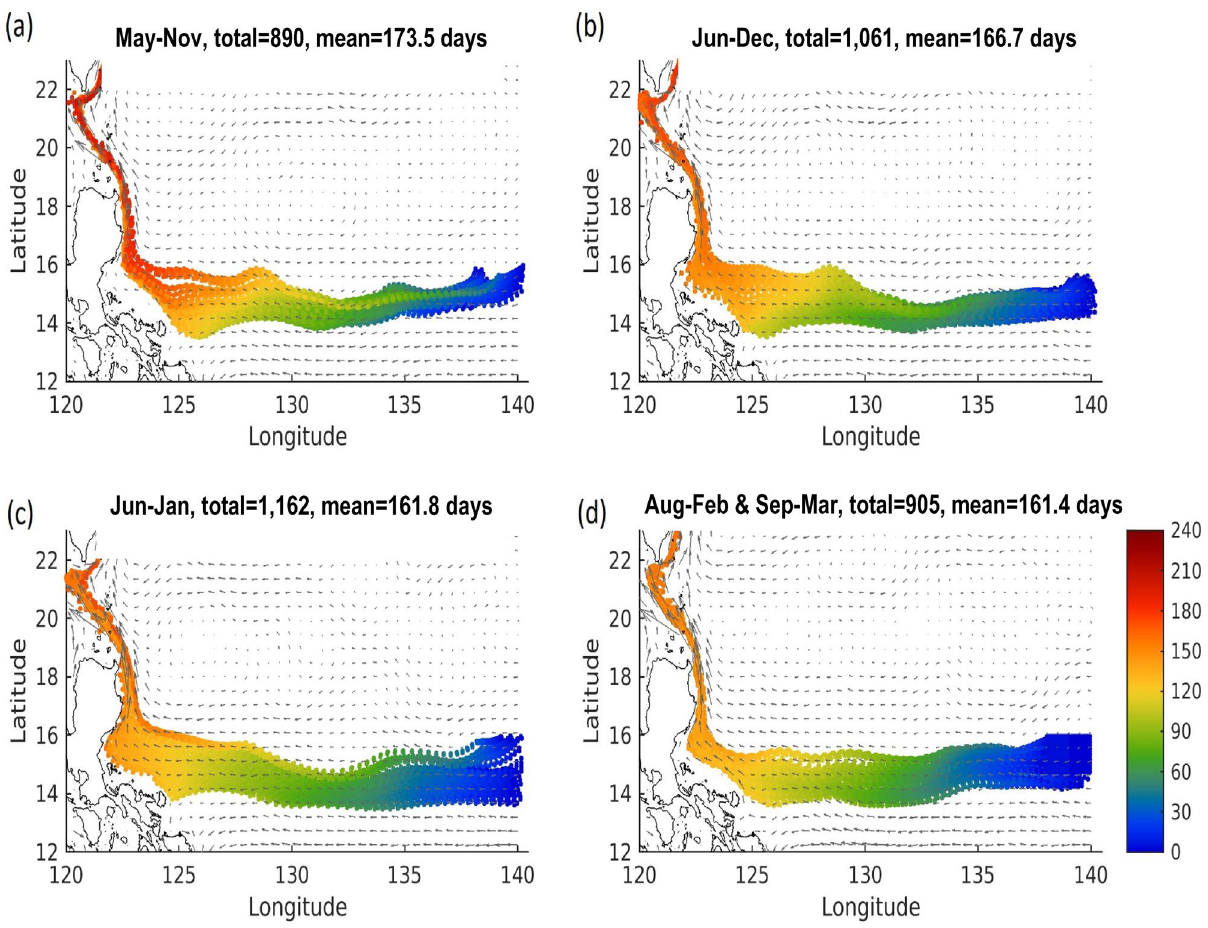
Figure 6. ( a ) The simulated transport pathways and times (color shaded) of larval Japanese eels from the spawning site (137–140° E, 14–16° N) to Luzon Strait released from May 1st. ( b – d ) released from June 1st, July 1st, and August/September 1st, respectively.